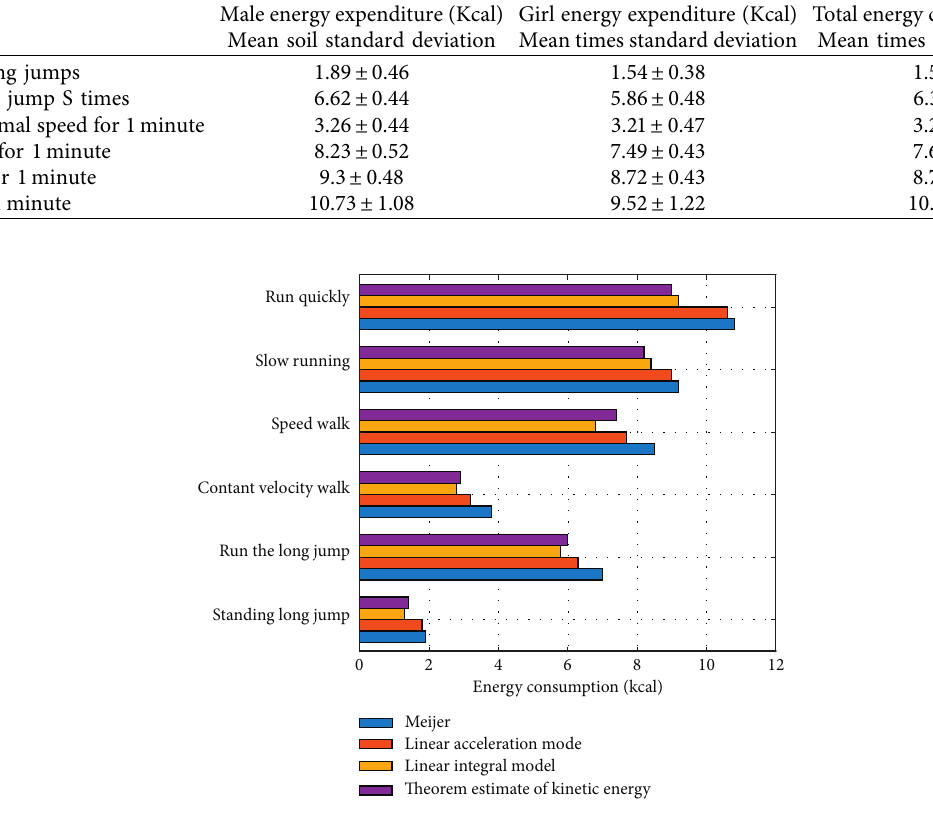
Figure 4: Comparison of average energy consumption calculated by different methods.